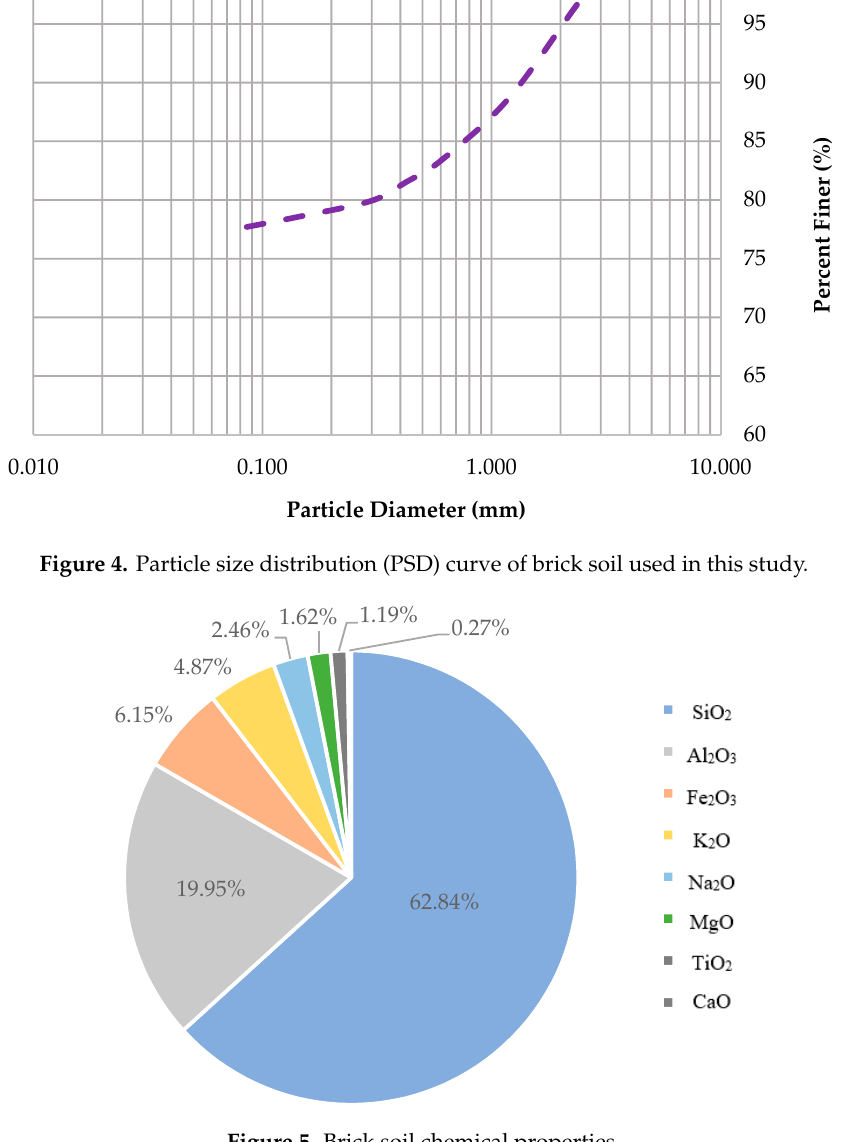
Figure 5. Brick soil chemical properties.